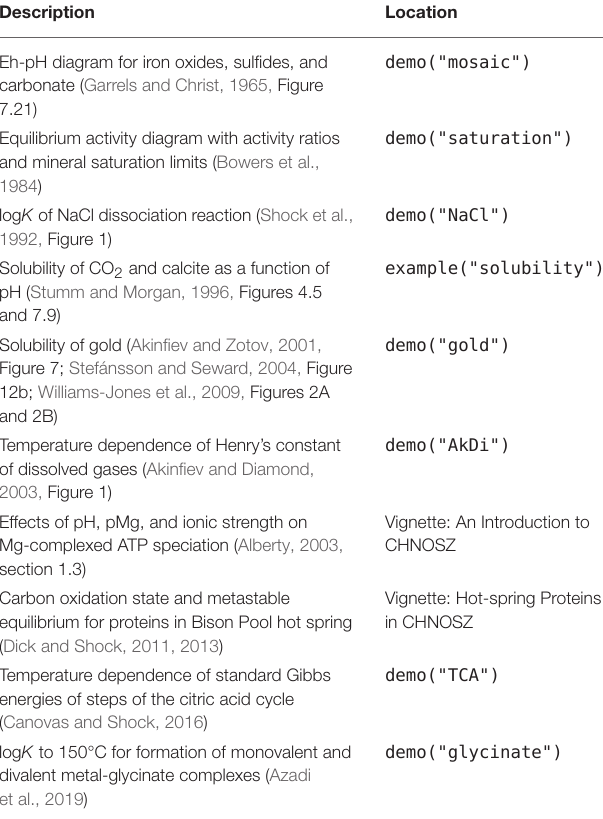
TABLE 1 | Selected reproductions of published calculations in the CHNOSZ package.